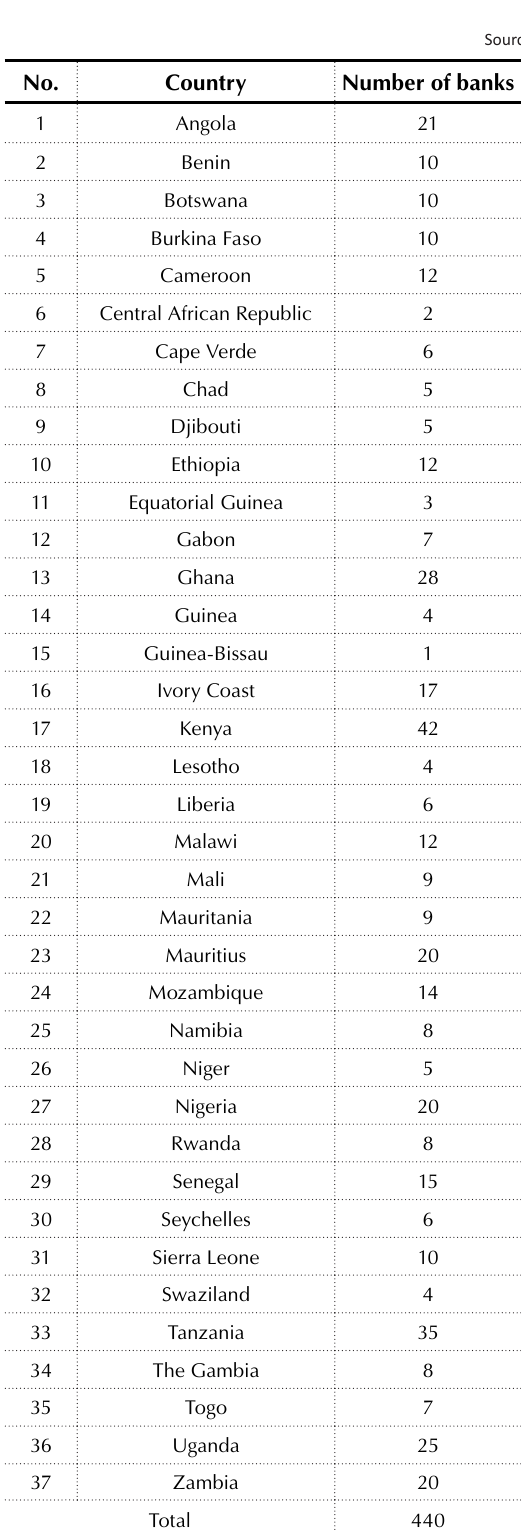
Table 1. Number of banks per SSA